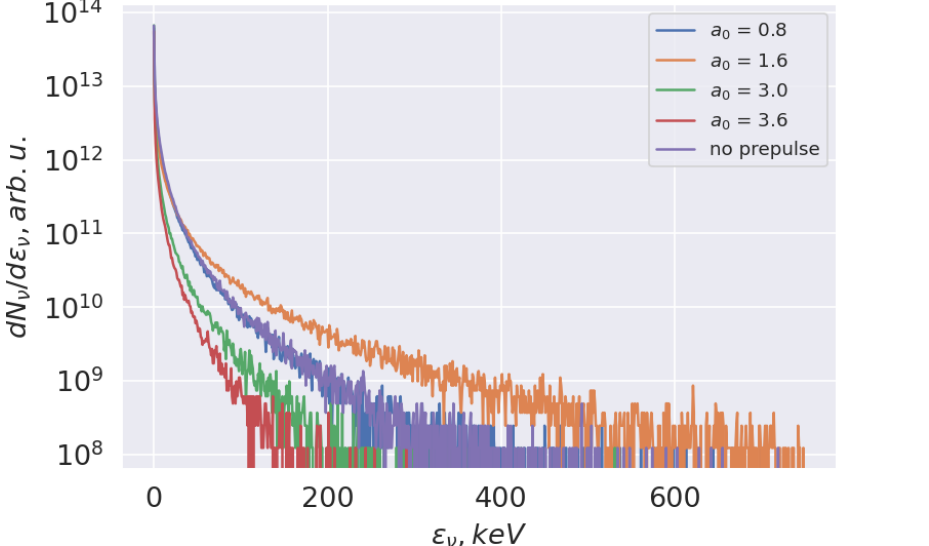
Figure 4. Comparison of photon spectra obtained from the simulations for 11 fs laser pulses with 5 fs prepulses with different